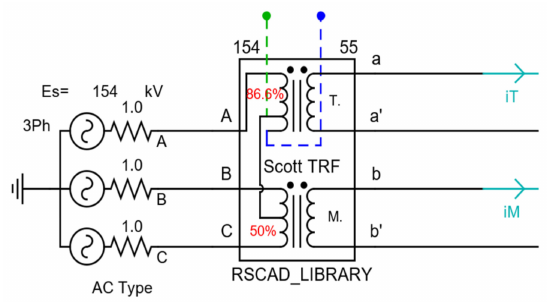
Figure 3. Scott transformer model in the Library of RSCAD.